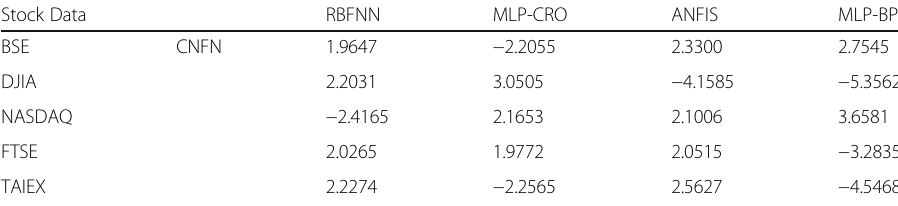
Table 9 Computed DM statistic values (one-day-ahead forecasting) Stock Data RBFNN MLP-CRO ANFIS MLP-BP BSE CNFN 1.9647 − 2.2055 DJIA 2.2031 NASDAQ − 2.4165 FTSE 2.0265 TAIEX